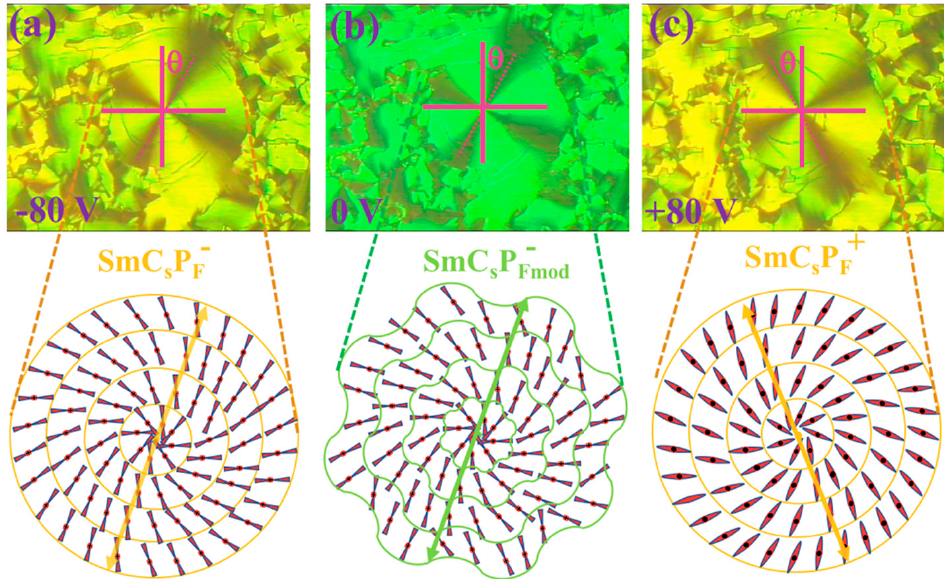
Figure 6. Representative POM textures of d = 4 µm B-10(S) film and their schematic director and layer structures of the circular area in the center of the image in the SmC PFmod phase at 127 °C. ( a ) While − 80 V applied; ( b ) after the field is turned off; ( c ) when +80 V is